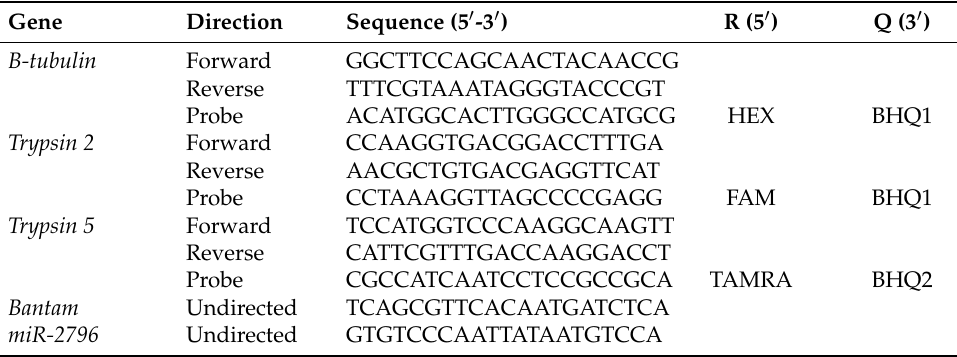
Table 2. Primers and probes used for RT-qPCR expression